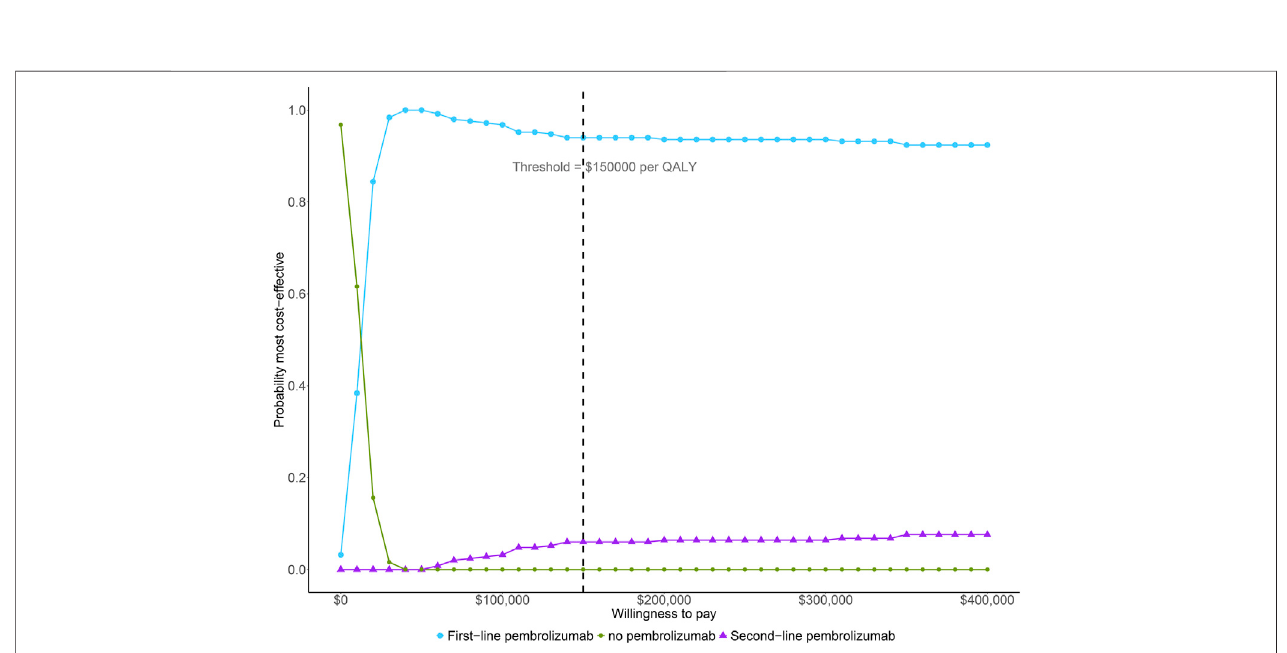
FIGURE 3 | The cost-effectiveness acceptability curve simultaneously comparing the cost-effectiveness of three competing strategies. QALY, quality-adjusted life year.